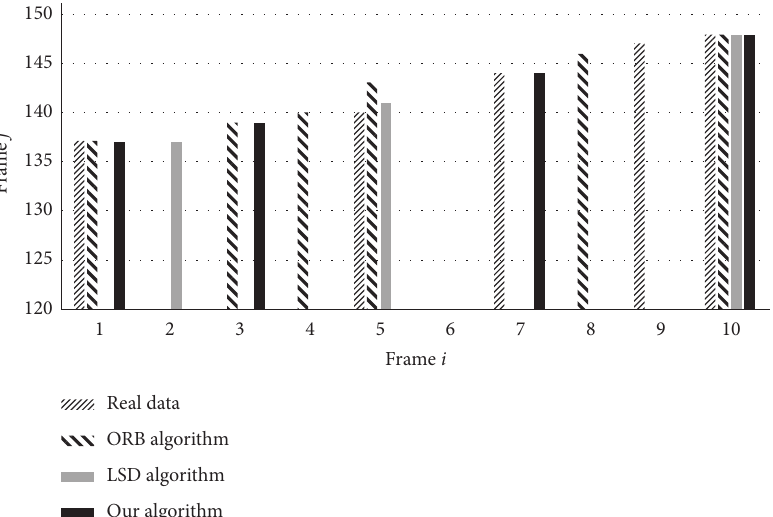
Figure 9: Comparison of loopback test results. Figure 9, the horizontal coordinate indicates the first ten sheets in the dataset, and the vertical coordinate indicates the image order number of the corresponding dataset detected as a loop by the algorithm, which is the value of the histogram.